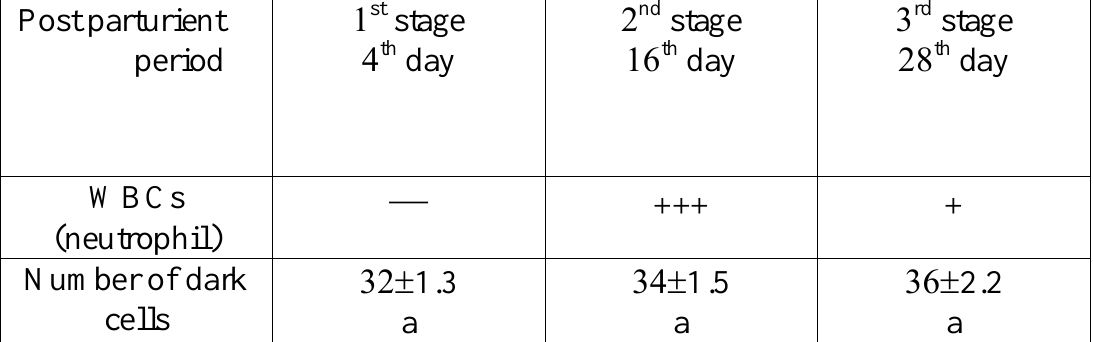
Table 3: Shows presence of WBCs (neutrophil) and cytoplasmic color during post parturient periods in Awassi ewes